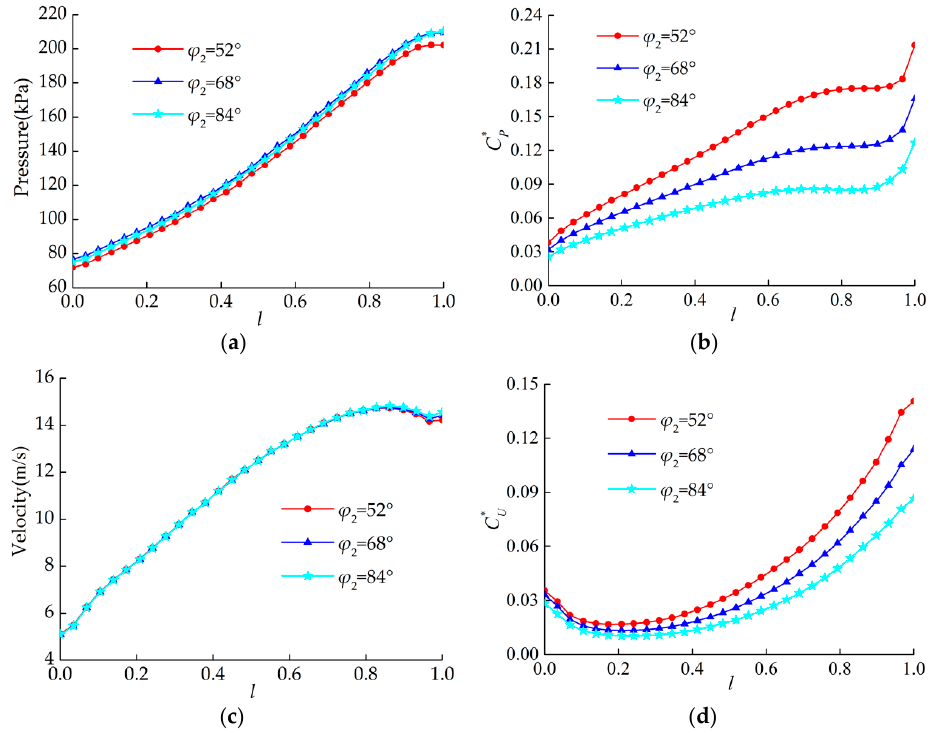
Figure 14. The time-average and the fluctuation intensity curves of pressure and velocity on the blade